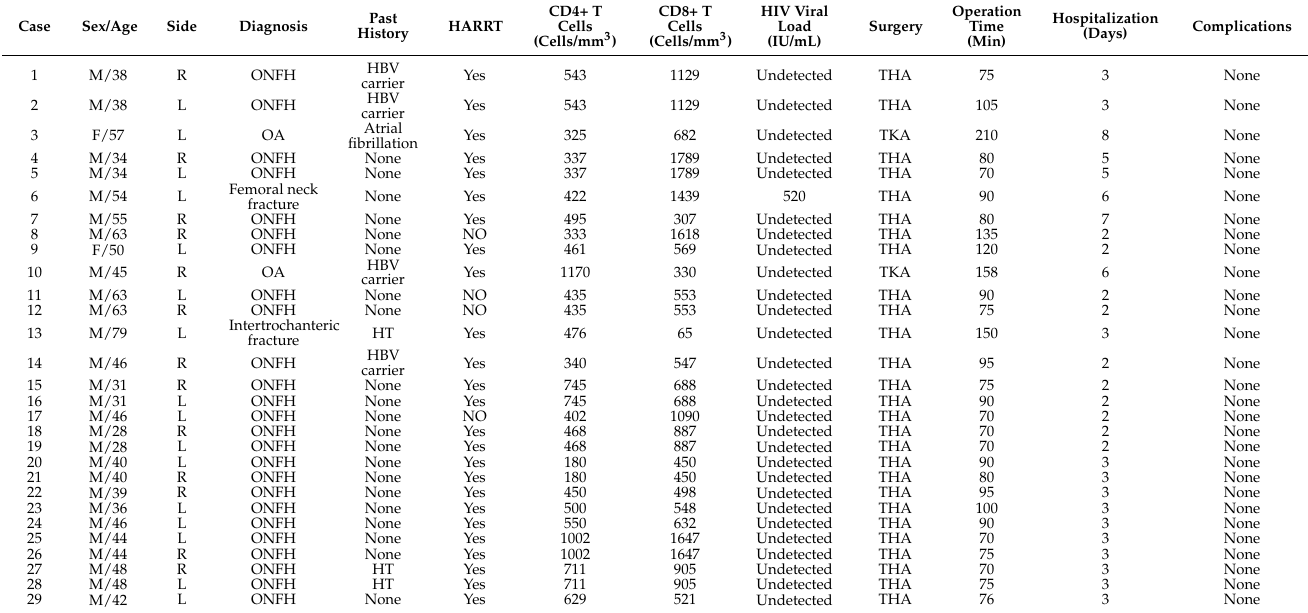
Table 1. Demographics of 21 HIV patients undergoing 29 joint replacement surgeries.